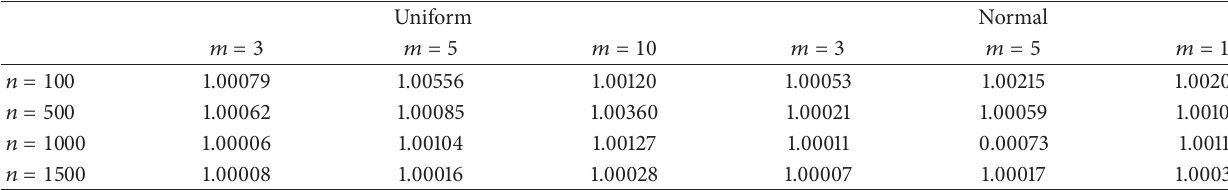
Table 4: Z(LB4)/Z(LB3) in the SPTA-A sequence.